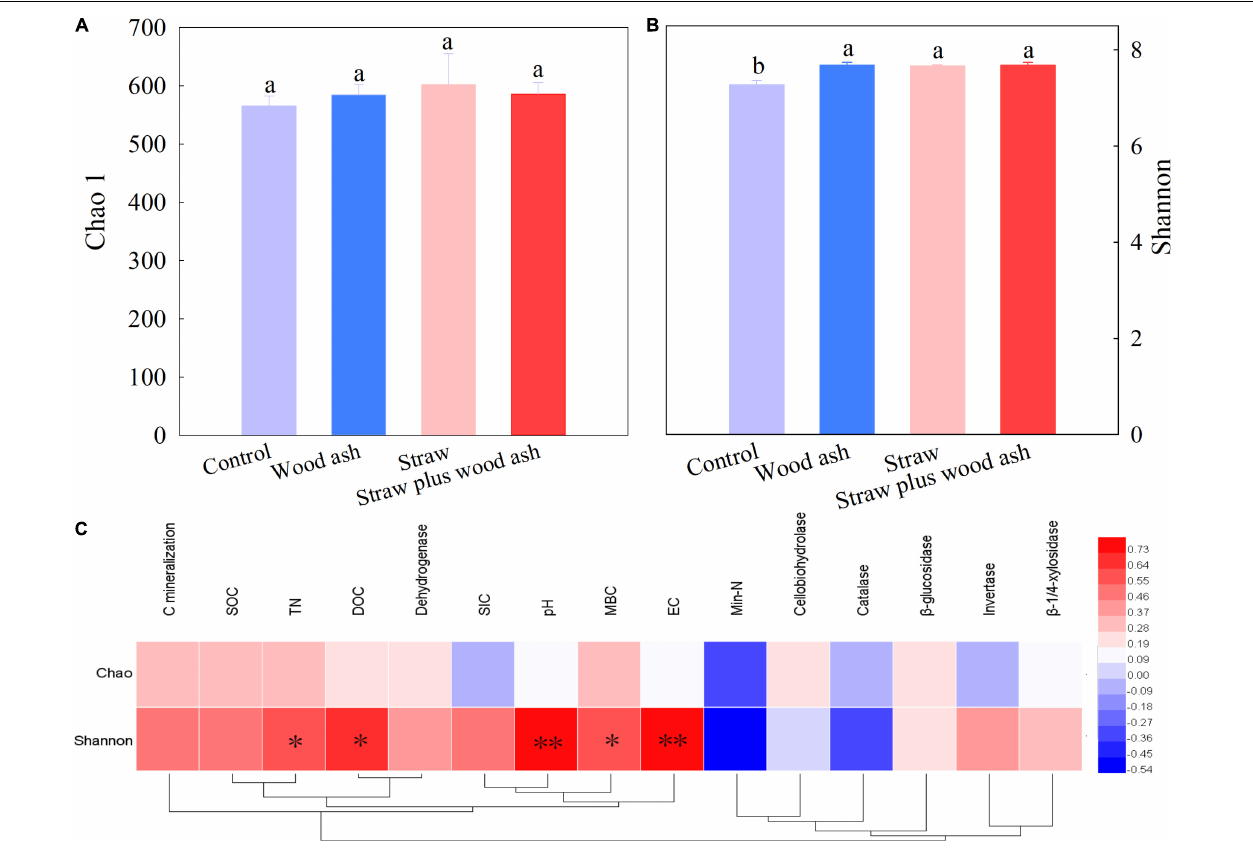
FIGURE 2 | (A,B) The richness of soil bacterial community and the diversity of soil for each treatment after incubation for 118 days. (C) Pearson’s correlation coefficients between alpha diversity and soil properties. ∗ P < 0.05; ∗∗ P < 0.01. Data (means ± SE, n = 3) followed by different letters indicate significant differences among the treatments at p <